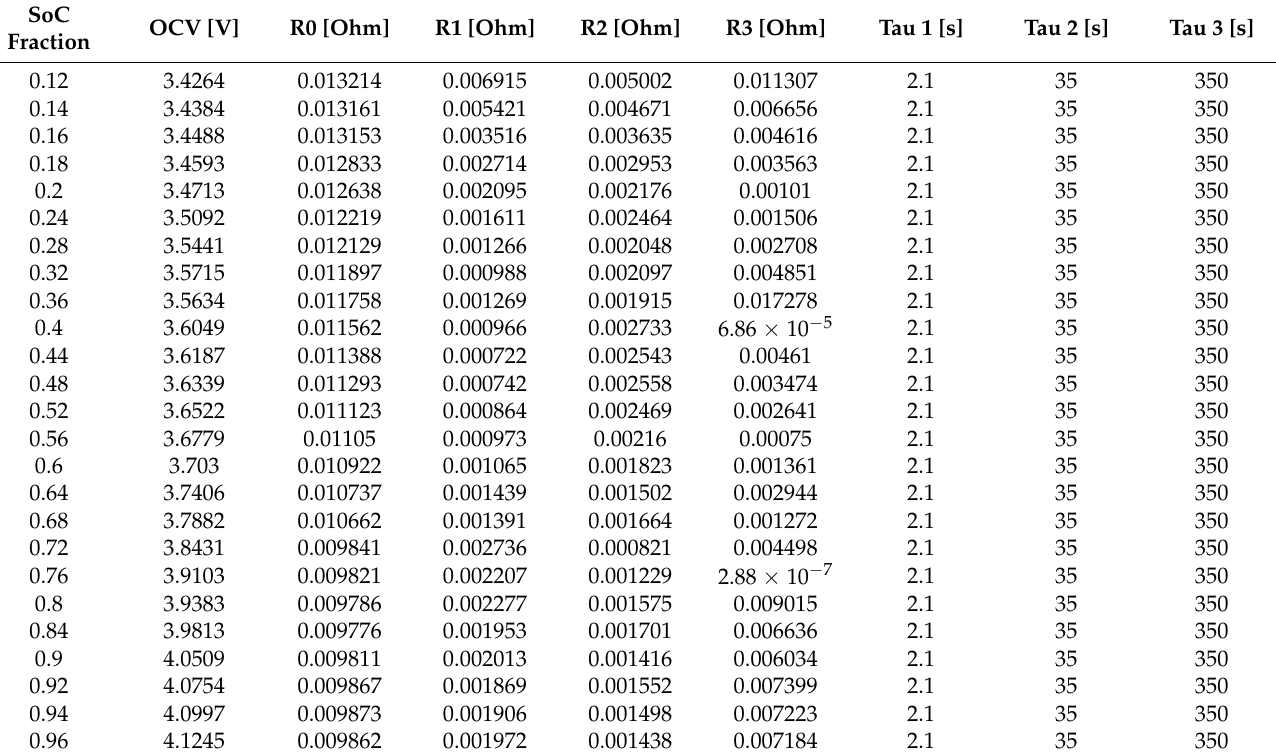
Table A1. ECM results from GITT in a climate chamber at 10 ◦